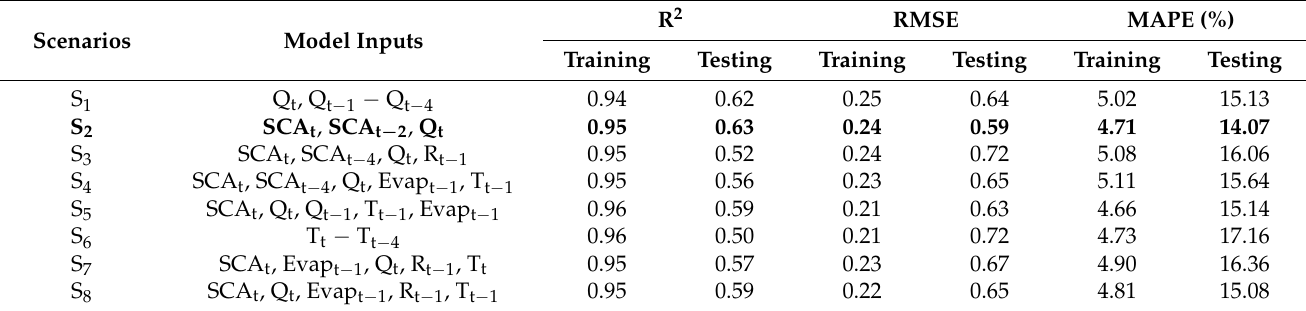
Table 7. Training and testing statistics of the M5Tree algorithm using various input combinations for the Gilgit River